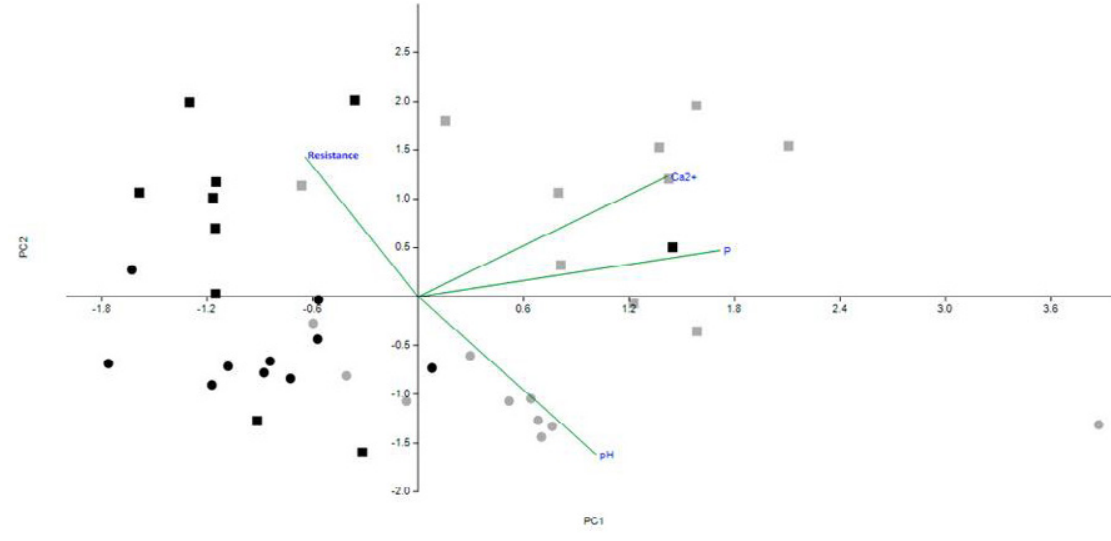
Fig 1 . Main component analysis of macronutrients (Ca2+, P), pH and soil resistance to root penetration. (Colours: black = red soil, grey = white soil; Square = mound; Circle = adjacent